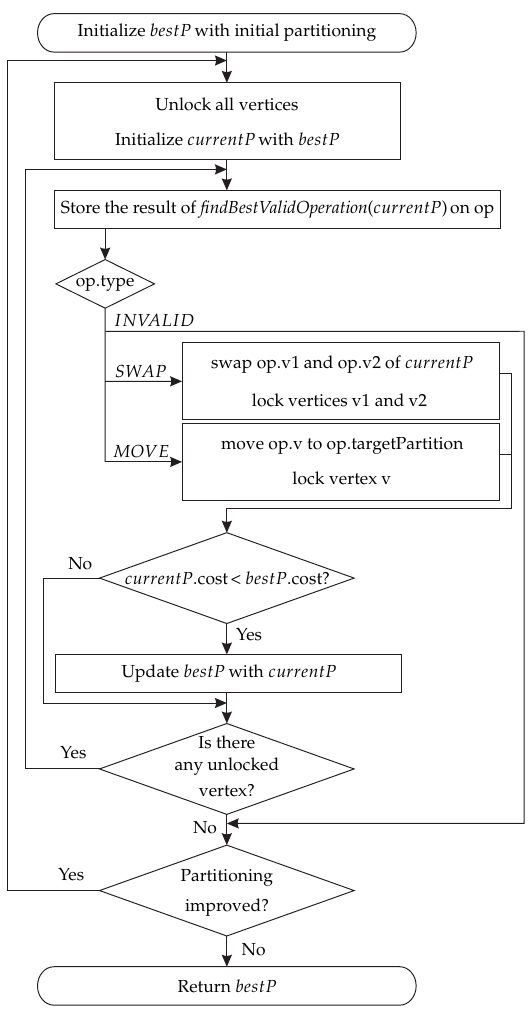
Figure 2. Flowchart of Algorithm